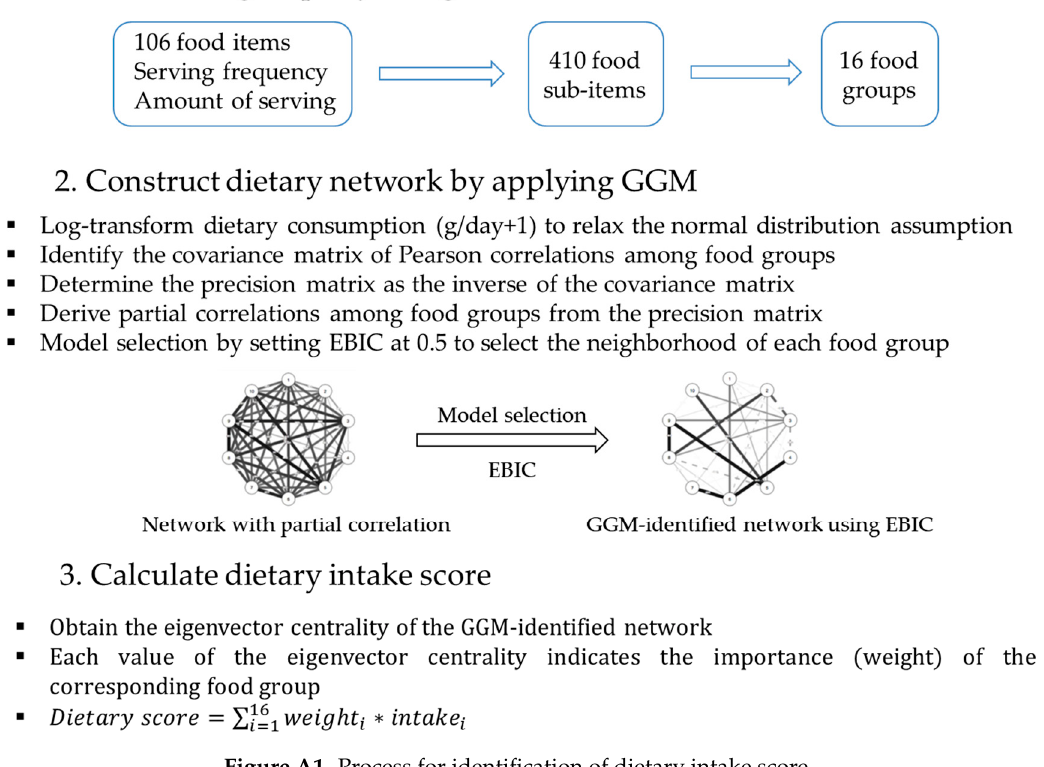
Cancers 2020 , 12 , x Figure A1. Process for identification of dietary intake score. Figure A1. Process for identification of dietary intake score.